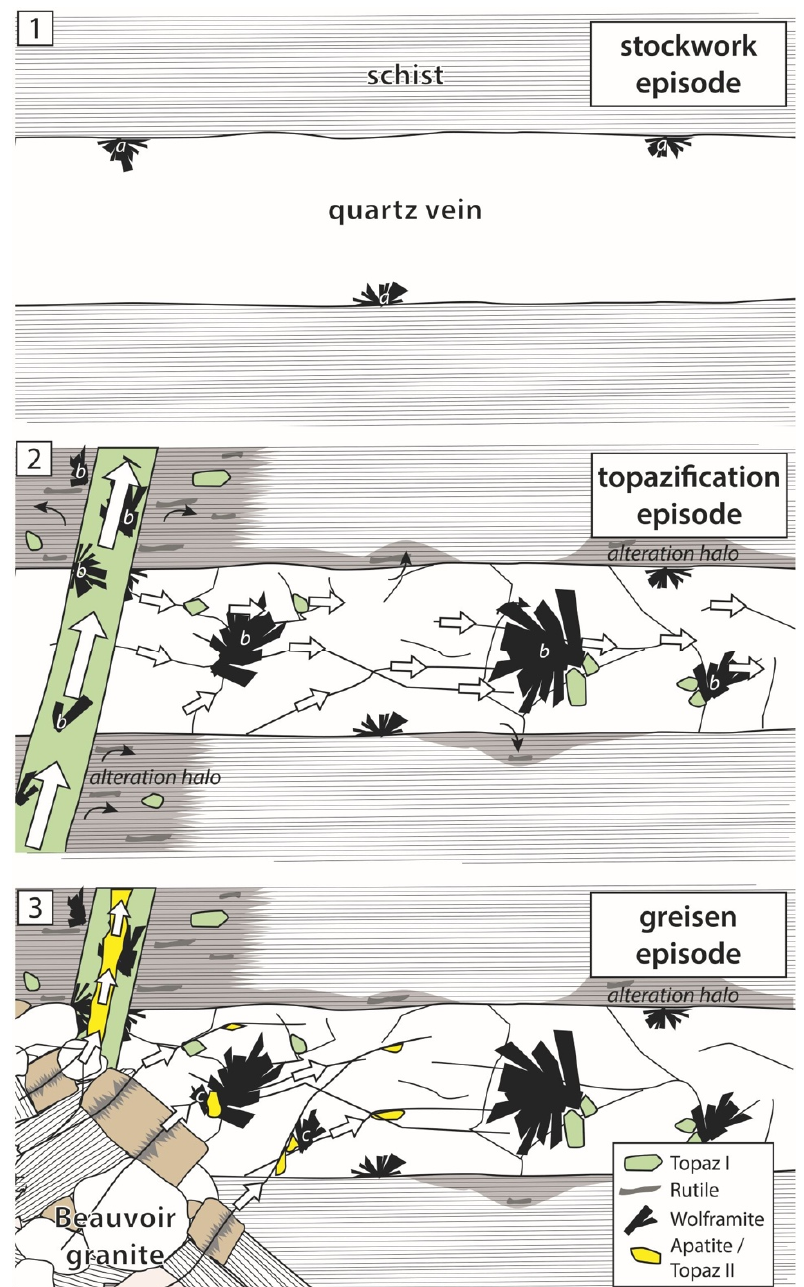
Figure 13. A schematic illustration depicting the succession of the three wolframite mineralizing episodes in the La Bosse stockwork. Emplacement of quartz veins in schist during formation of the stockwork, with precipitation of wolframite a. A silica‐undersaturated F‐rich alteration episode induced formation of topaz veins, topazification of pre‐existing quartz veins, and metasomatism in the schist. Abundant wolframite b precipitation occurred during this stage. Emplacement of the Beauvoir granite and subsequent greisen alteration produced further fluid circulation, which affected the stockwork, in a limited way only, by precipitating topaz (II) in reactivated topaz veins, as well as apatite and wolframite c in quartz veins.